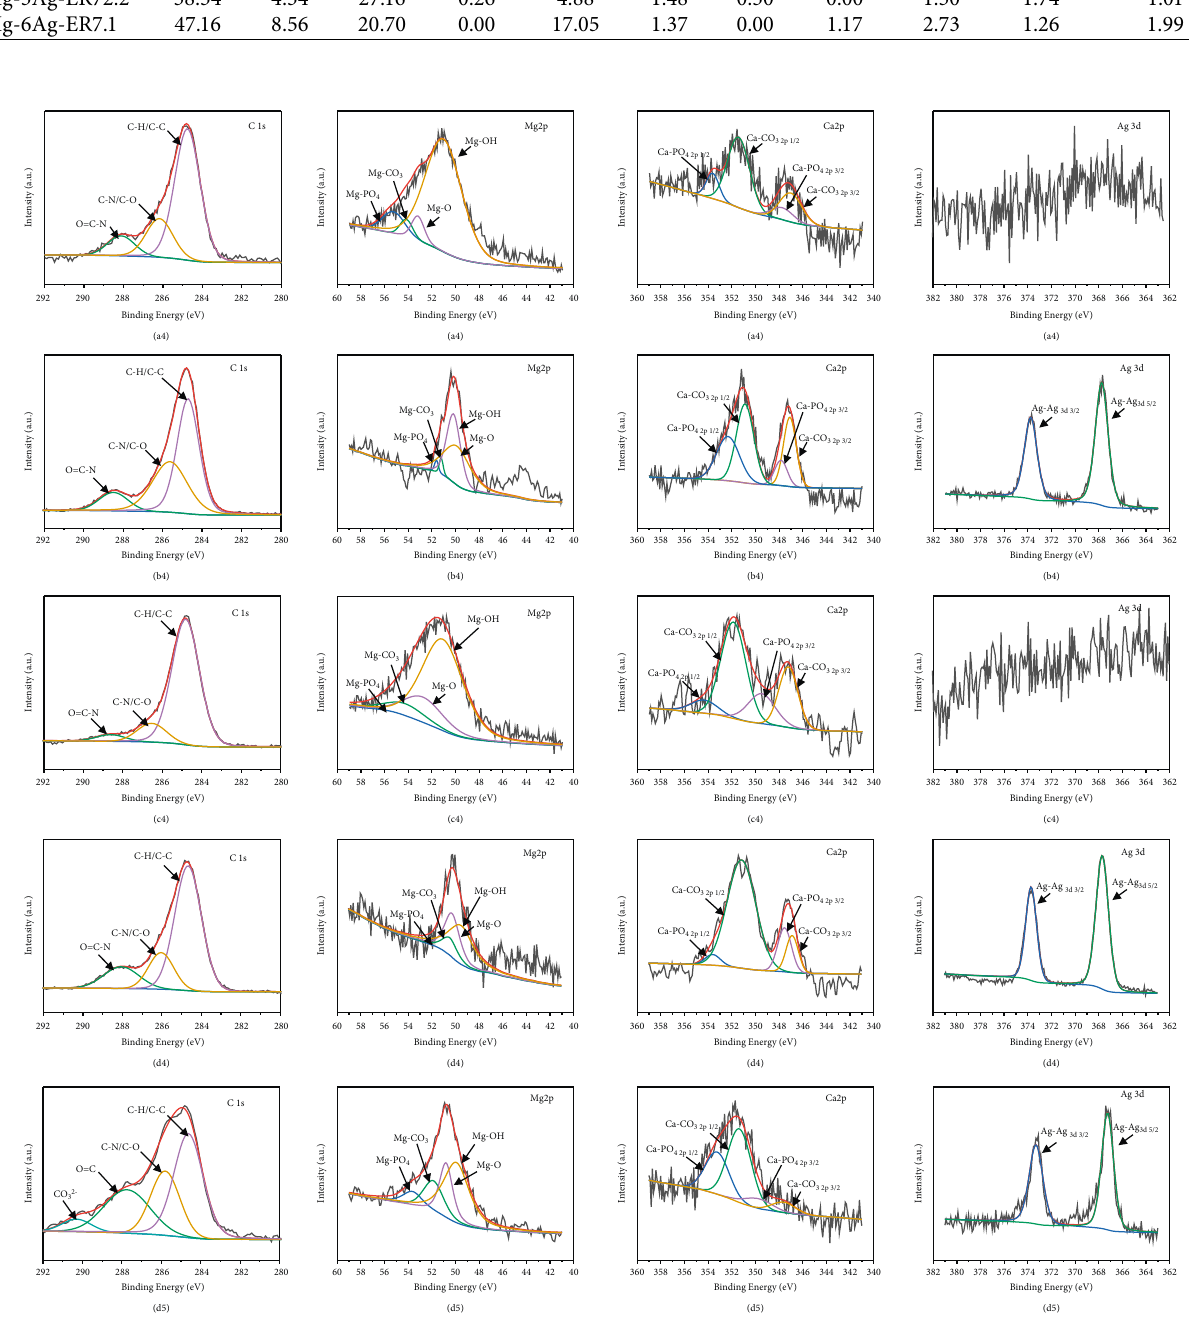
Figure 8: High-resolution spectra for C 1s, Mg 2p, Ca 2p, and Ag 3d signals of the surfaces of (a cast, (c 1 –c 4 ) Mg-3Ag-ER7.1, (d 1 –d 4 ) Mg-3Ag-ER72.2, and (e 1 –e 4 ) Mg-6Ag-ER7.1 after an immersion test for 16 days.